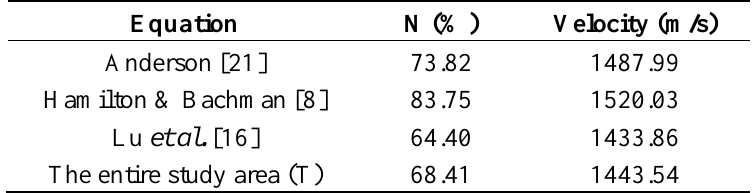
Figure 4. Porosity versus sound velocity; H is Hamilton and Bachman [8] equation, AH is Hamilton and Bachman [8] abyssal hill equation; A is Anderson [21] equation; L is Lu et al. [16] equation; T is the equation established in the paper; S is the shallow area equation; D is the deep area equation; the star (*) point indicates shallow area measurement points and the dot (●) point indicates deep area measurement points. Table 1. The empirical equations of N values and corresponding sound